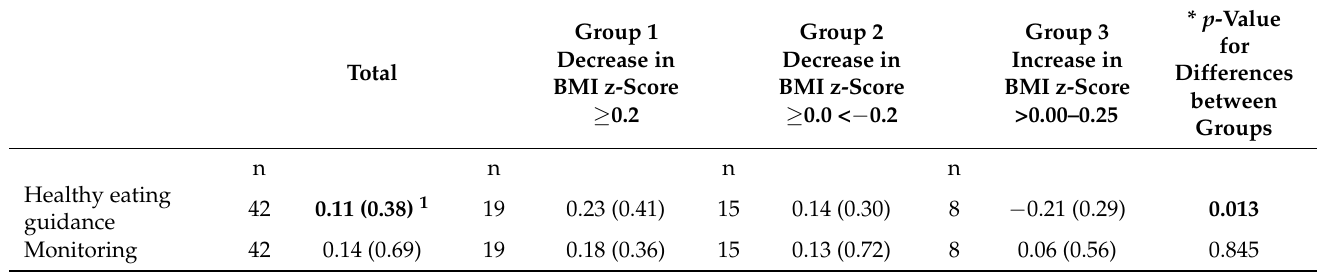
Table 8. Changes to food parenting practices according to BMI z-score